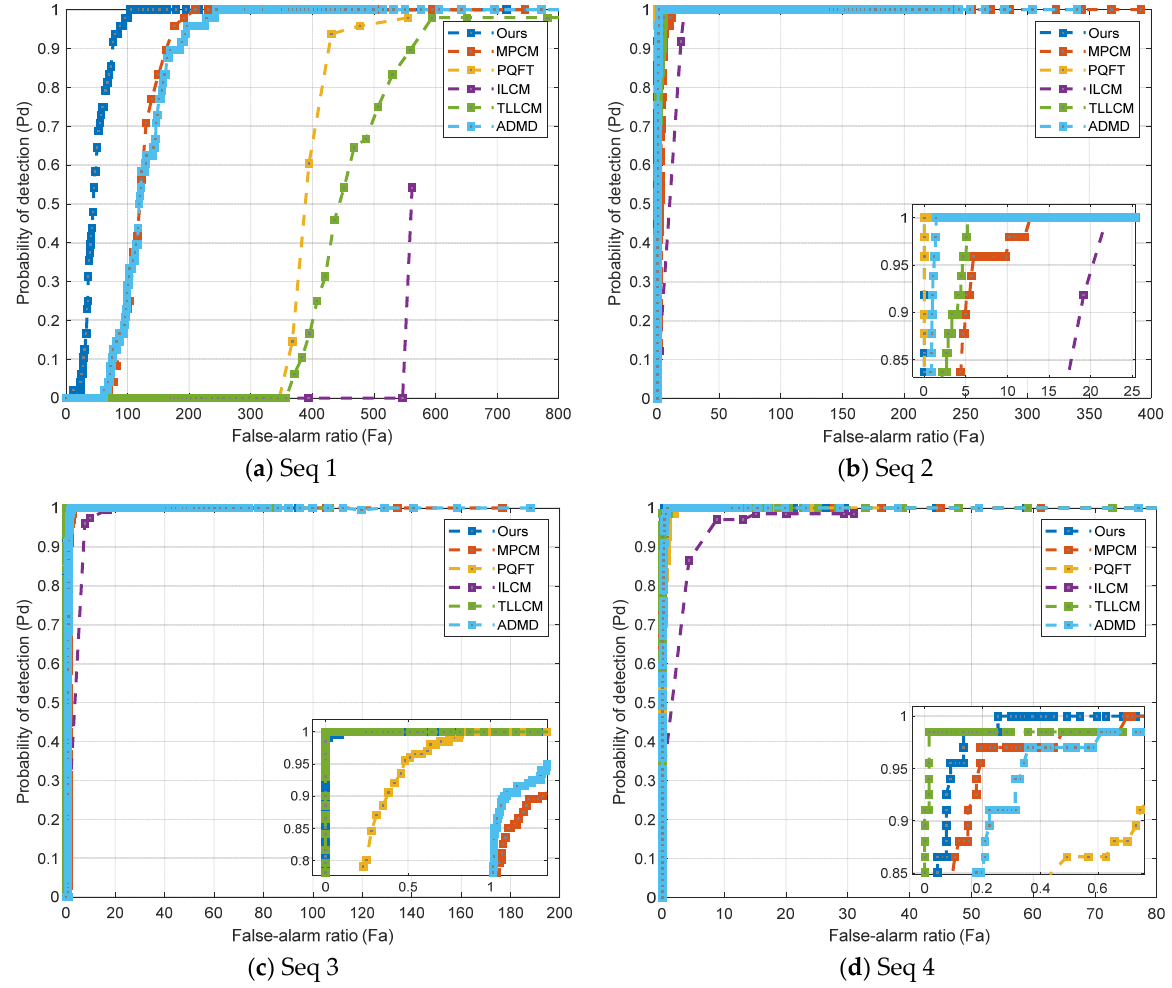
Figure 7. ROC curves of the proposed method and baseline methods in Seq 1–4.